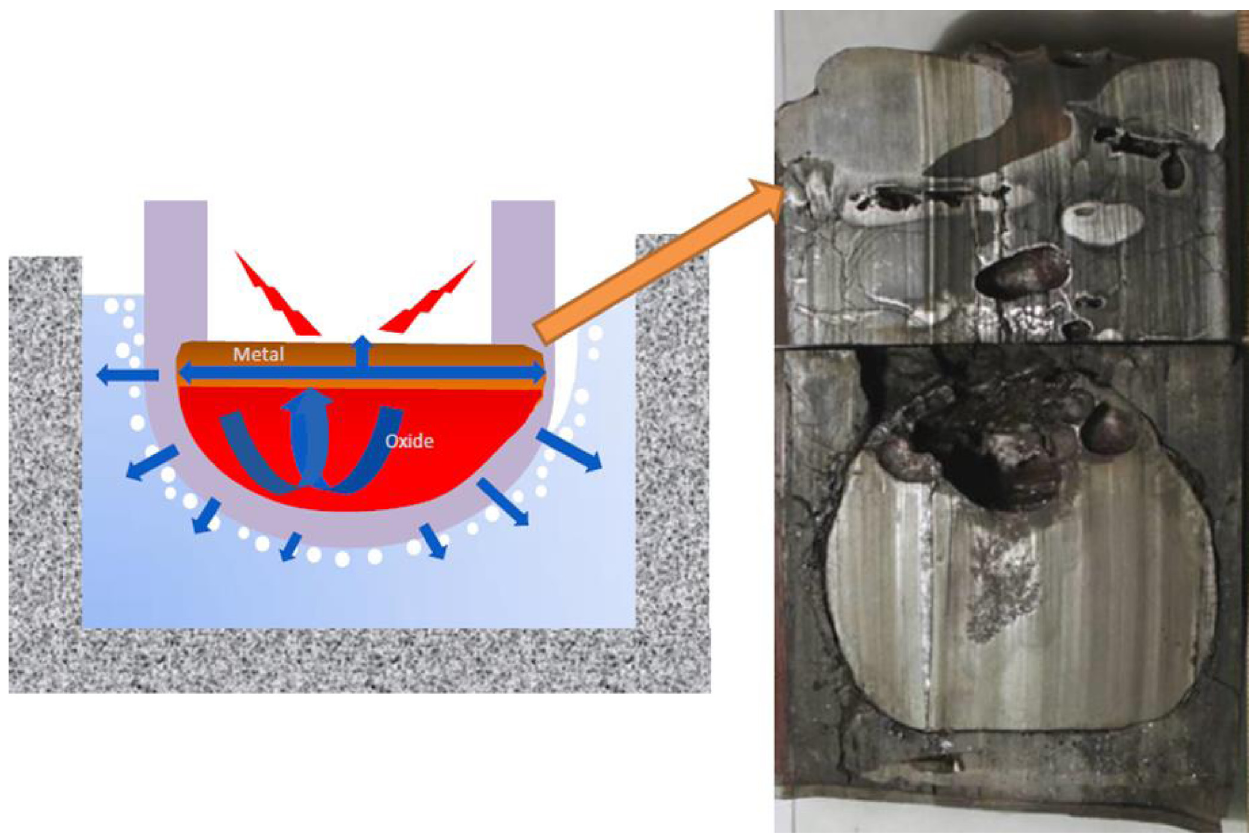
Fig. 3. CORDEB-2 experimental data ( © NITI,